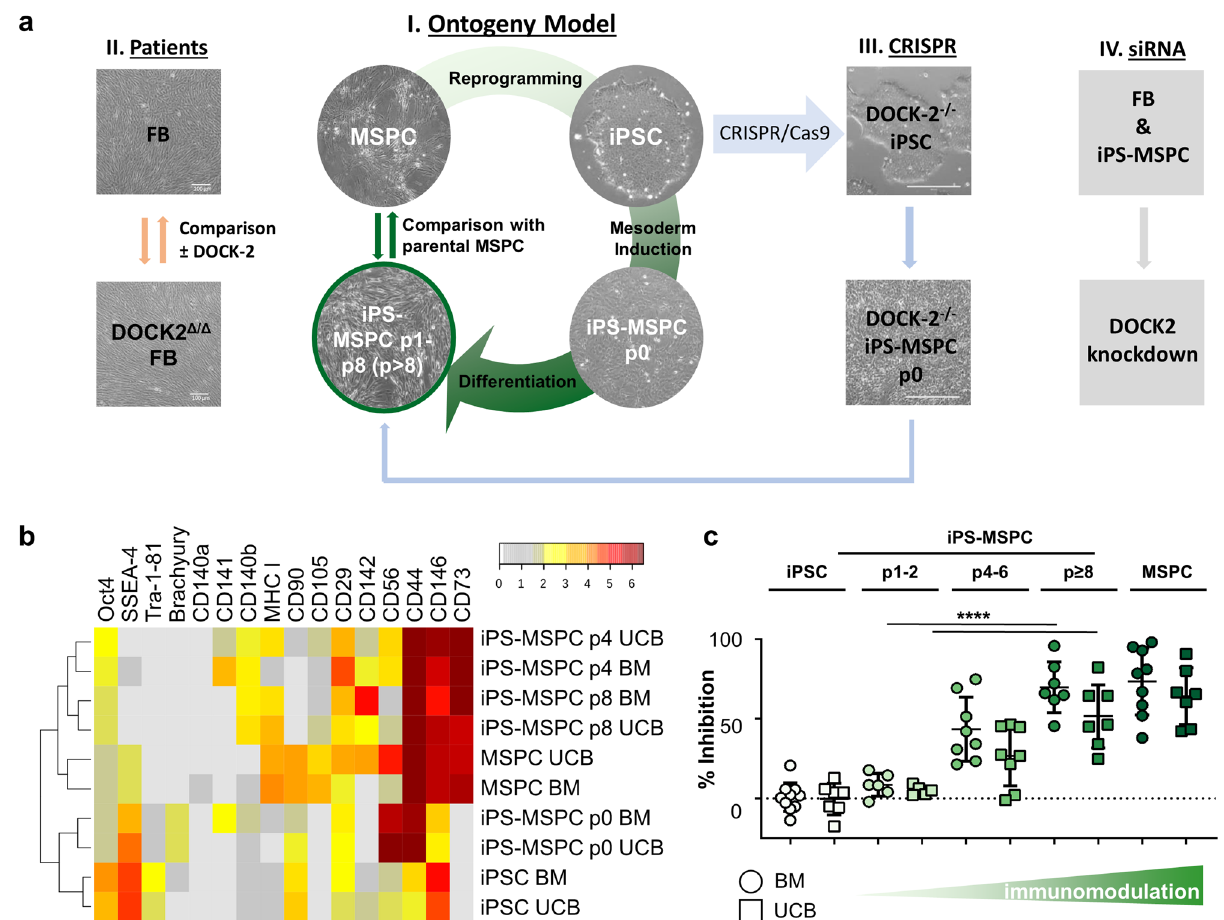
Fig. 1 Human iPS-MSPCs undergo continuous maturation towards reacquisition of immune modulatory potential. a Experimental setup: I . MSPCs derived from bone marrow (BM) and umbilical cord blood (UCB) were reprogrammed into iPSCs before mesoderm induction and maturation into mesodermal iPS-MSPCs to enable sequential gene expression and functional pro fi ling. II . DOCK-2 mutated patient fi broblast (FB) lines were compared to healthy controls for phenotype and immunomodulation. III . Healthy iPSCs were used for CRISPR/Cas9-mediated bi-allelic DOCK-2 knockout, subsequent DOCK-2 -/- iPS-MSPC propagation and function comparison. IV . Healthy control FB and iPS-MSPCs were subjected to si-RNA-mediated DOCK2 knockdown to determine the immediate effect of reduced DOCK2 GEF presence in stromal cells during immunomodulation. b Cluster analysis of single cell-based fl ow cytometry marker pro fi ling during differentiation of MSPC-derived iPSCs back into iPS-MSPCs. Mean Δ MFI values (speci fi c antibody staining minus isotype control) from passage 0 (p0) to p8, compared to parental MSPCs. c Immunomodulatory potential of iPS-MSPCs inhibiting T-cell mitogenesis at 1:3 ratio iPSCs or MSPCs:immune cells increased with differentiation from early to late passages compared to parental primary MSPCs and iPSCs. (BM: iPSC n = 10, iPS-MSPC p1 – 2 n = 6, iPS-MSPC p4 – 6 n = 8, iPS-MSPC p ≥ 8 = 7, MSPC n = 9; UCB: iPSC n = 7, iPS-MSPC p1 – 2 n = 5,